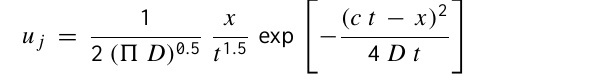
translation (advection) and redistribution (dispersion)